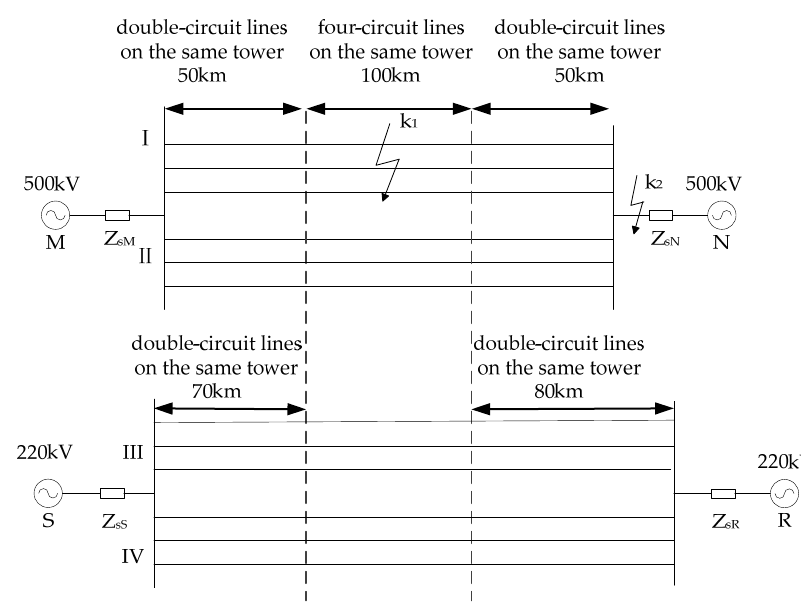
Figure 4. Simulation model of complex four - circuit lines on the same tower.